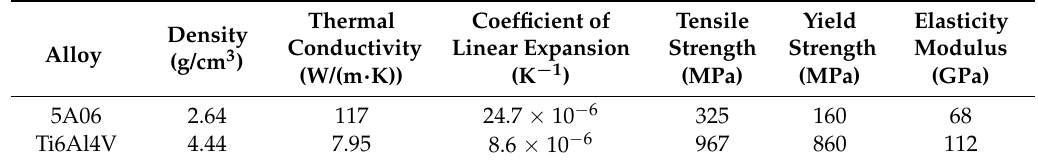
Table 2. Physical and mechanical properties of base materials: density (D), thermal conductivity (TC), coefficient of linear expansion (CLE), tensile strength (TS), yield strength (YS), and elasticity modulus (EM).